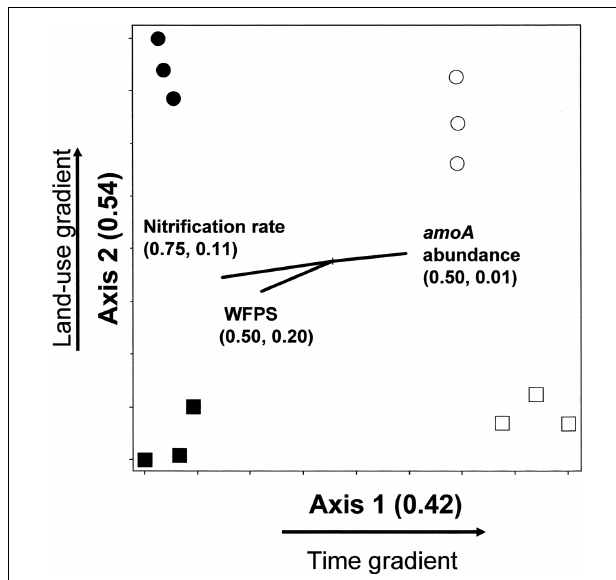
FIGURE 3 | Non-metric multidimensional scaling ordination of nitrifying communities based on presence/absence of operational taxonomic units (OTUs) defined by amoA RFLP patterns. (cid:2) = Jun 01; ◦ = Jun 01; cultivated wetlands. (cid:3) = Sep 12; cultivated wetlands. • = Sep 12; uncultivated wetlands.Vectors show uncultivated wetlands. the direction and magnitudes of the correlation coefficient ( r 2 ) between NMS ordination axes and functional variables.The r 2 for the correlation between functional variable and axis 1 and axis 2 are in parentheses (in the order r 2 to axis 1, r 2 to axis 2).